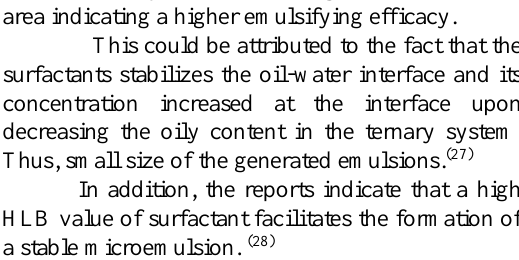
Figure 4. Solubility studies of tacrolimus (a) in various oils; (b) in various surfactants; (c) in various cosurfactants.